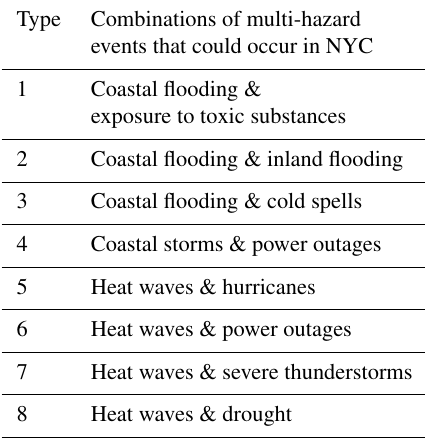
Table 4. List of multi-hazard events that the city should adapt to as these could occur in the future.